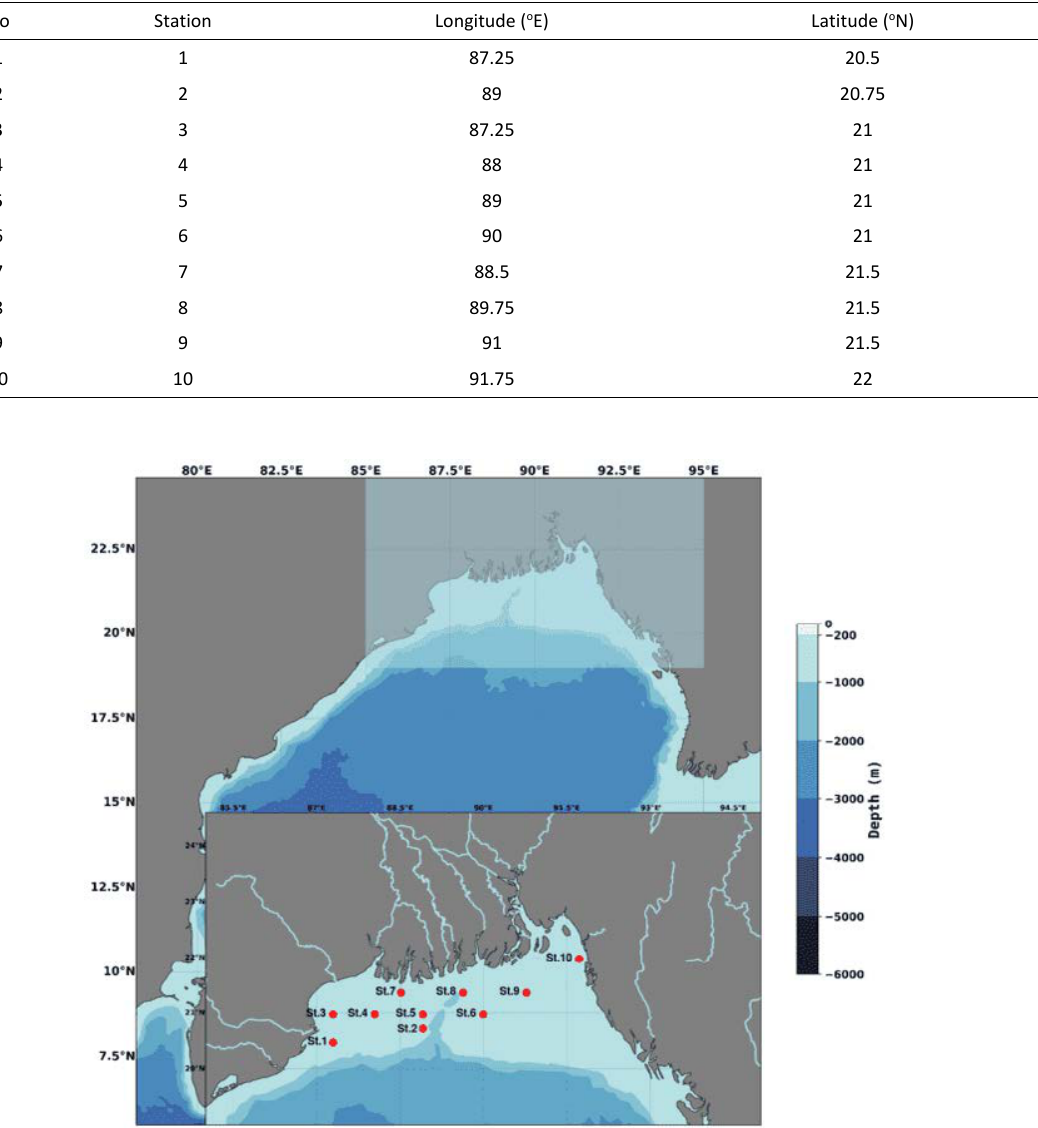
Table 1: Study station location